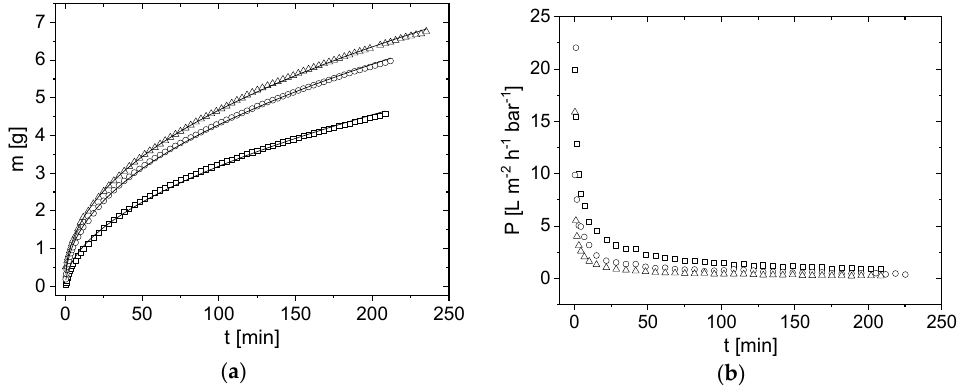
Figure 5. ( a ) Permeate mass m as a function of filtration time t for the three different feed pressures p = 0.25 bar (squares), p = 0.75 bar (circles) and p = 1.25 bar (triangles) at ϑ = 22 °C. Each membrane has